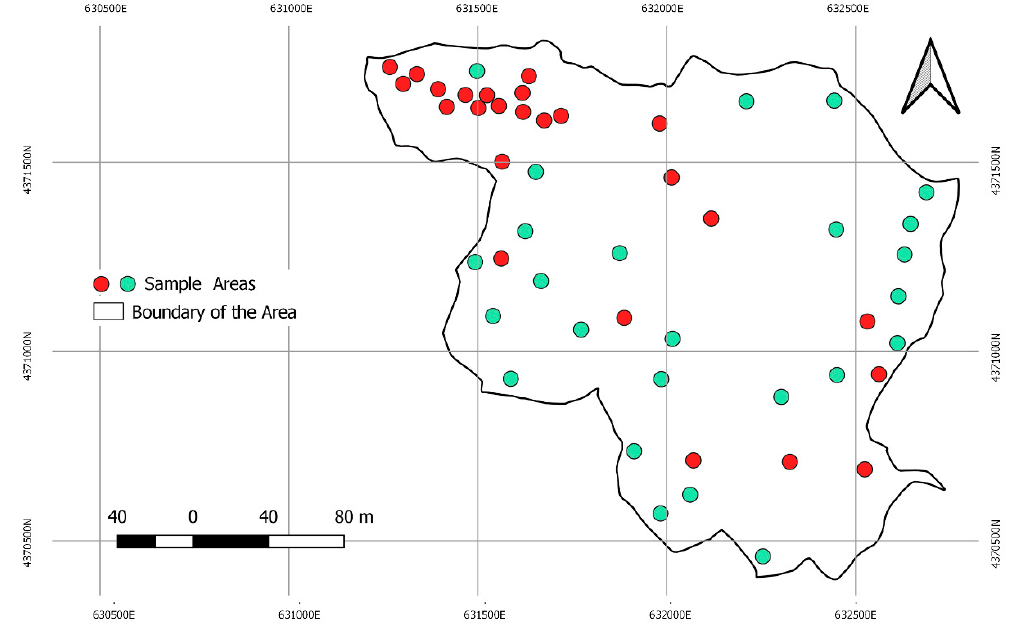
Figure 5. Sample plots randomly distributed within the study area Green areas are not subject to landslides; those in red are subject to landslides.